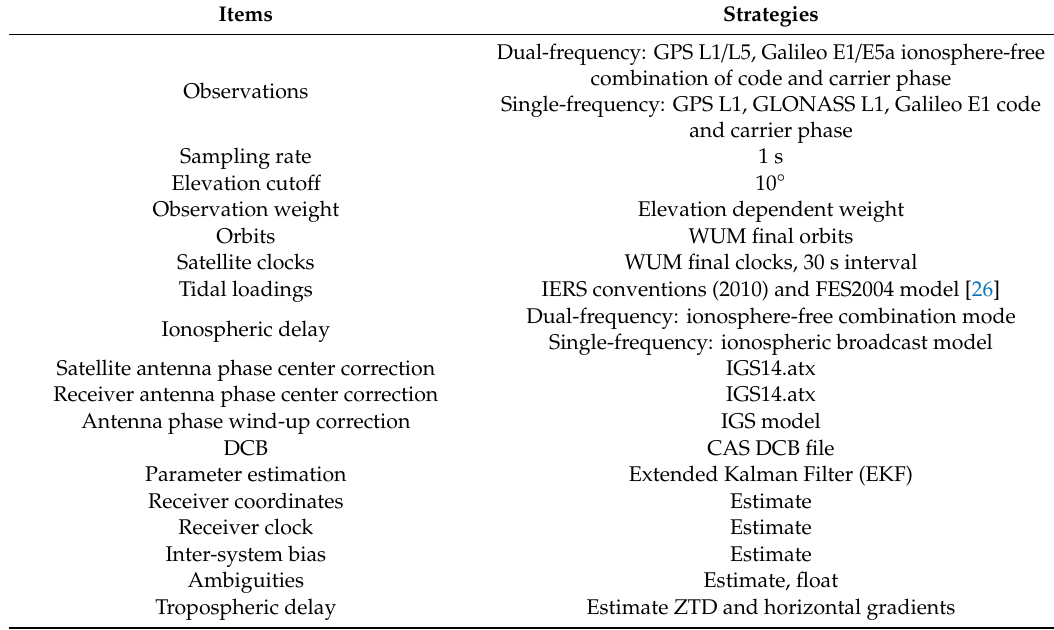
Table 1. Data processing